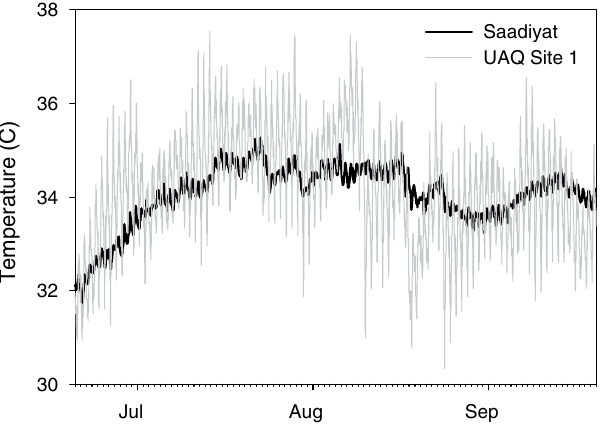
Figure 1. Water temperatures in the Umm Al Quwain lagoon and Saadiyat reef during summer